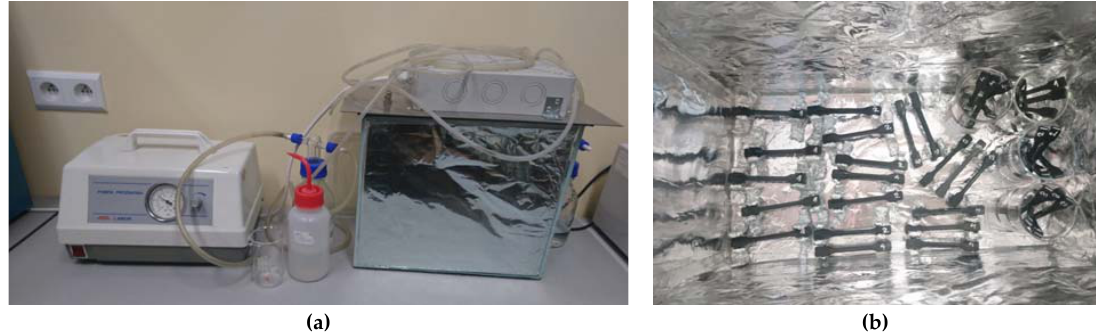
Figure 7. Aging chamber with UV lamps and vacuum pump ( a ) and the view of arranged samples in chamber ( b ).